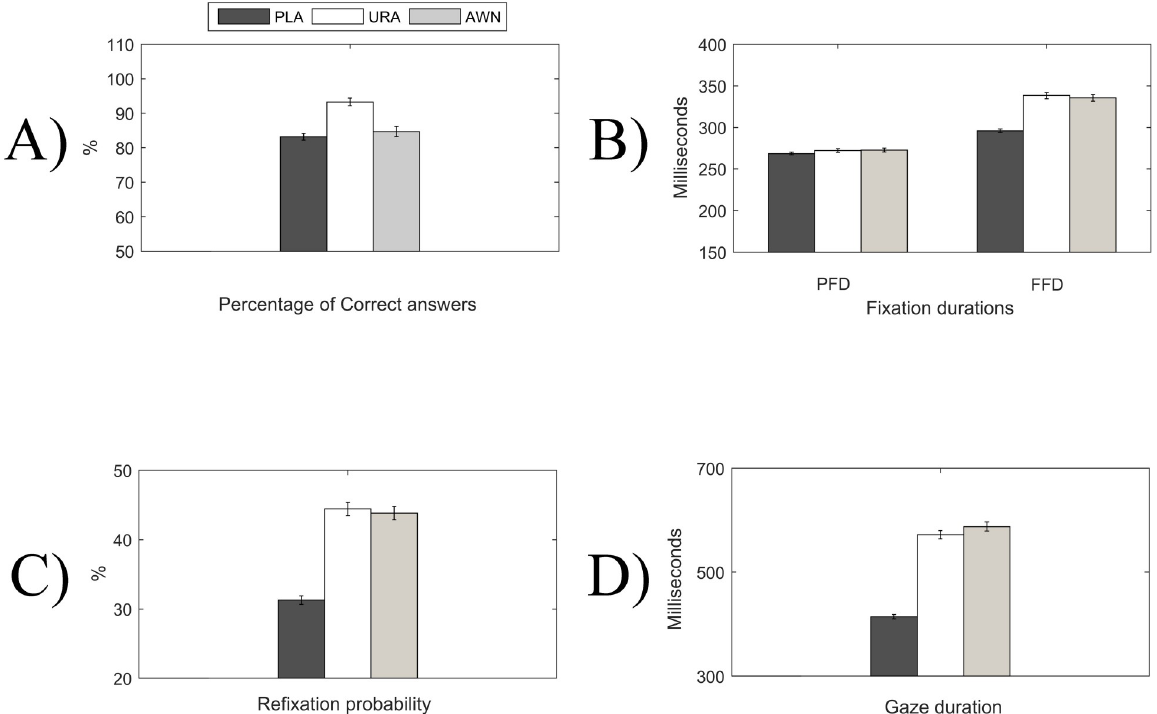
Fig 3. Behavioural measures. Bar graph presentation of the behavioural measures; exact values are presented in Table 3. A) Percentage of correct answers, B) Fixation durations of the previous fixation (PFD) and the first fixation (FFD) and C) Re-fixation probability (RFP) after the